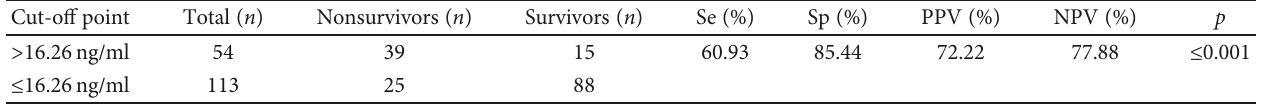
Table 3: Diagnostic accuracy of serum suPAR level at admission for predicting 3-month mortality in HB-ACLF patients. Cut-o ff